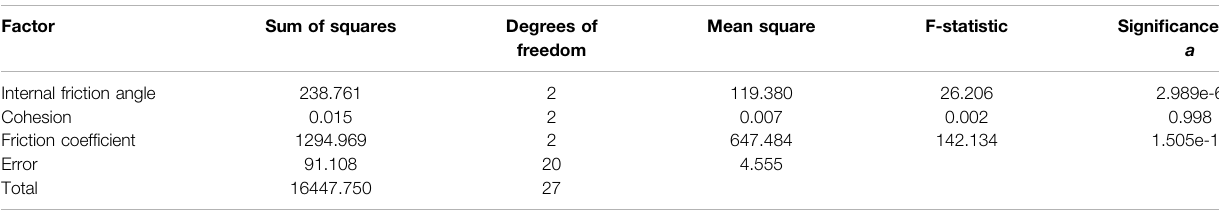
TABLE 3 | Variance analysis results for average velocity.